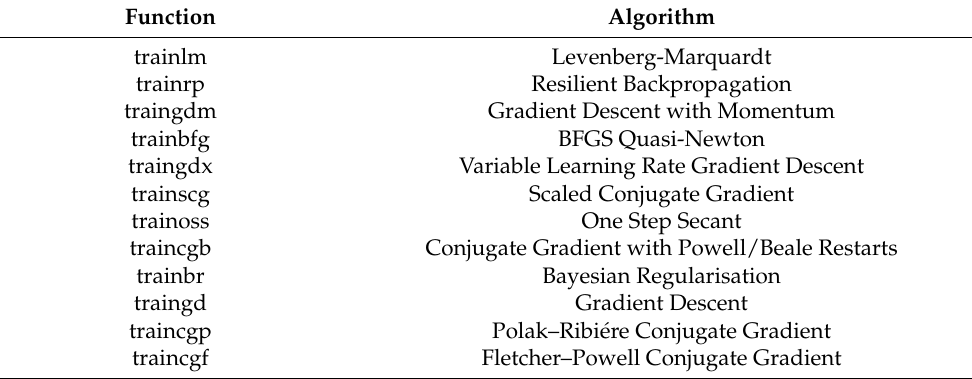
Table 5. Learning algorithm for weight optimisation within neurons in